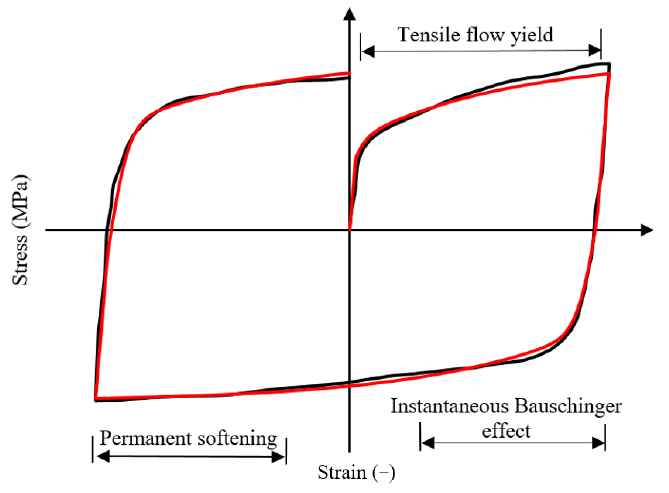
Figure 4. Intervals for VW-PSO.